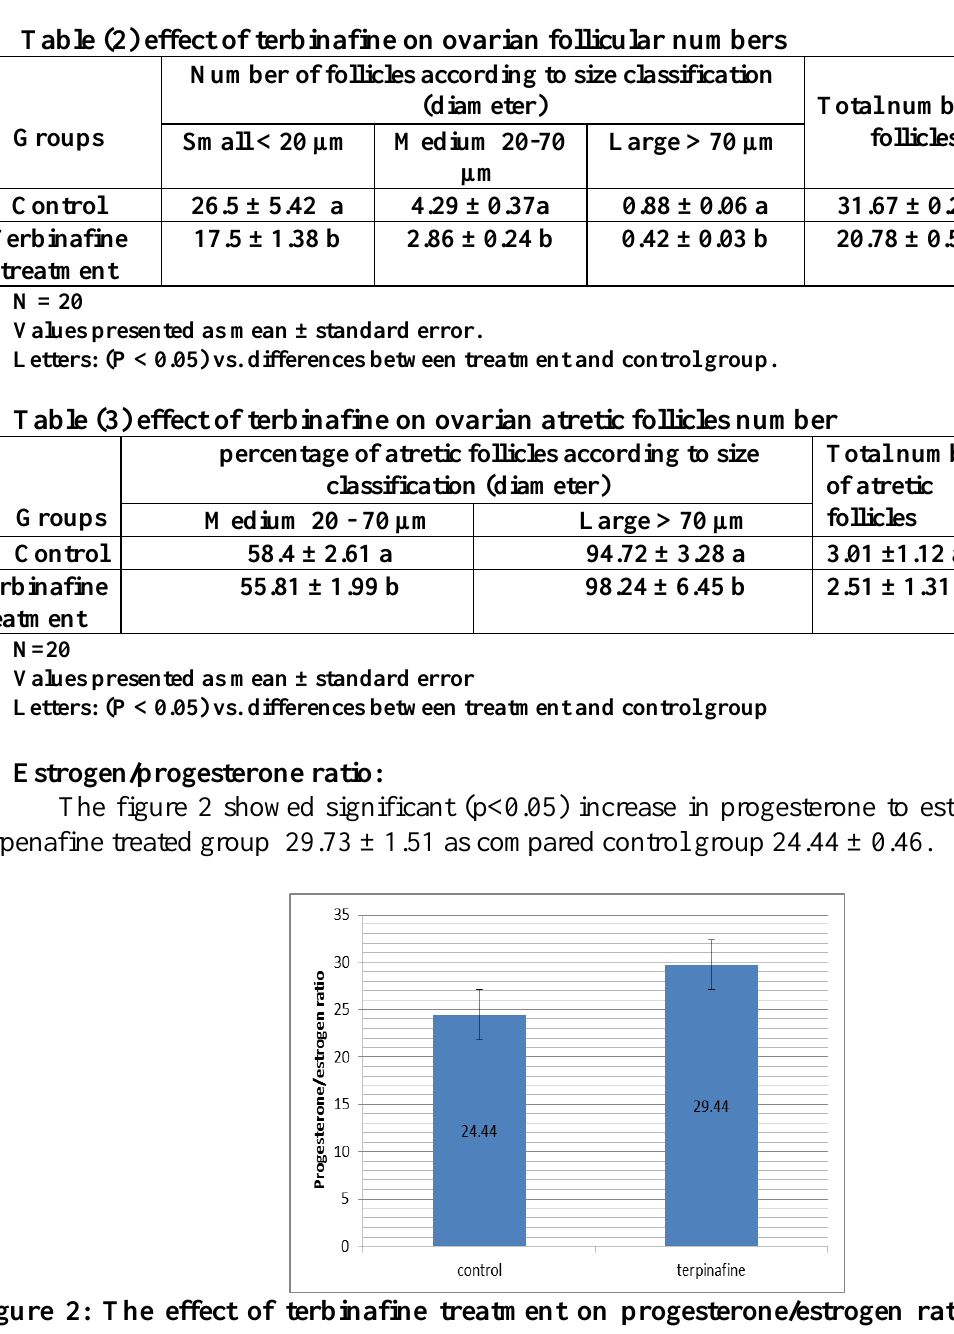
Body and organs